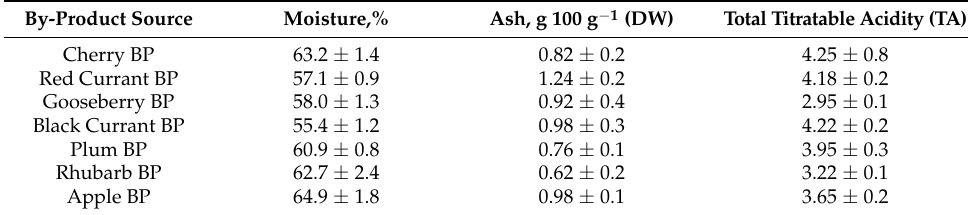
Table 2. Properties of pectin obtained from juice production by-products.